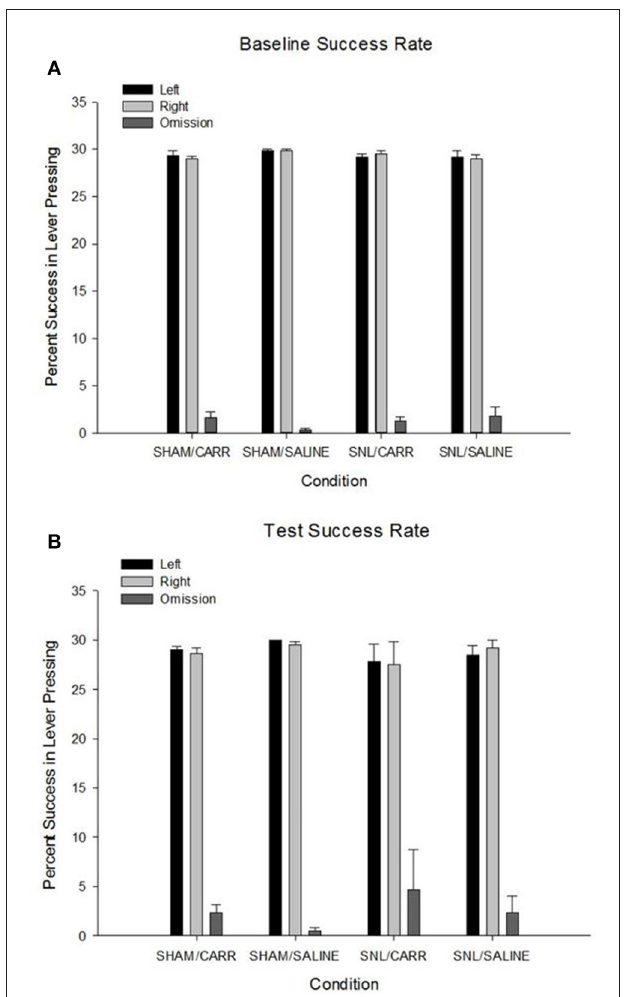
FIGURE 4 | Average latency in seconds ( ± SEM) to respond to the lever by pressing for the appetitive reward for left and right levers across baseline (A) and test days (B) . There were no differences in latency to lever-press across conditions in the